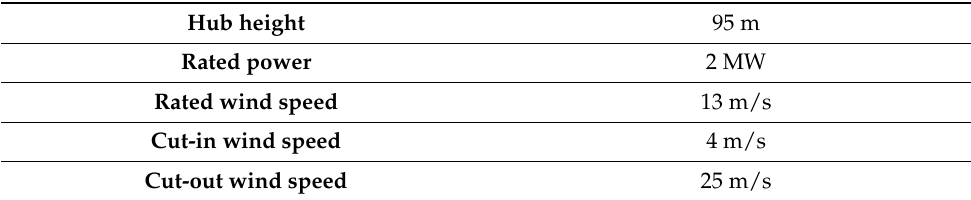
Table 3. Characteristics of the wind turbine [24].